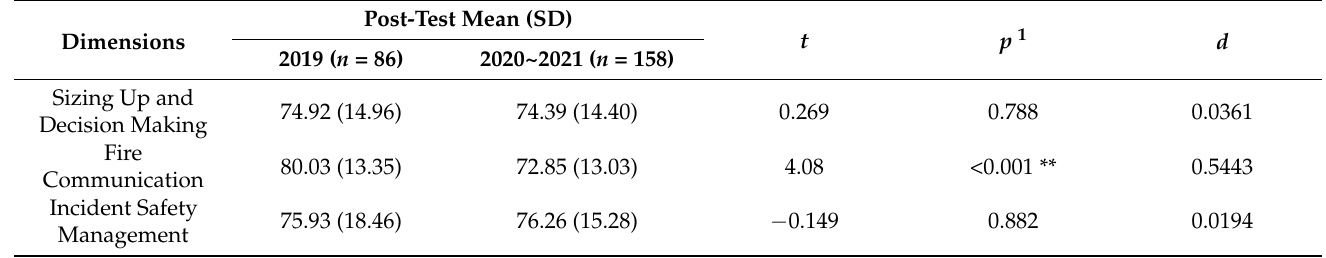
Figure 10. Box charts of trainees’ post-test scores before and during the epidemic. Table 4. T Test analysis of trainees’ post-test scores before and during the